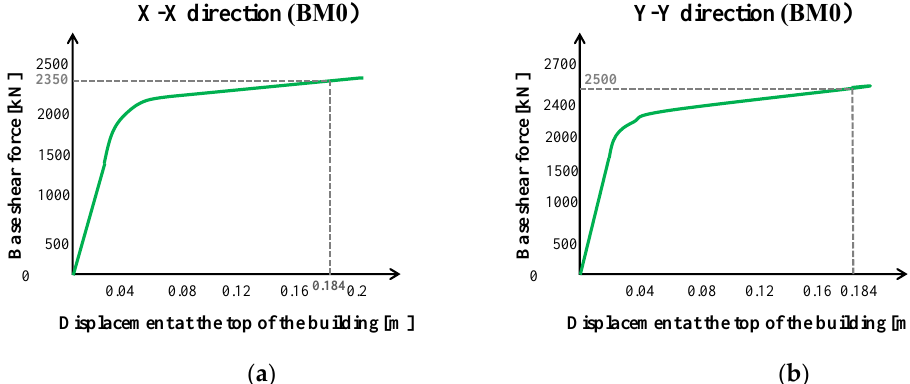
Figure 8. Pushover curves of BM0 :( a ) x-x direction; ( b ) y-y direction.